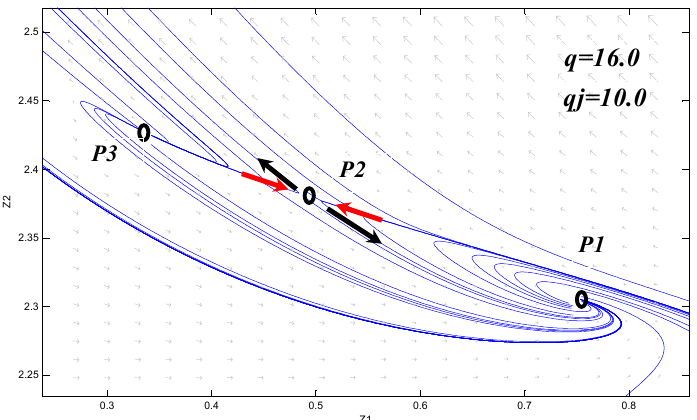
Figure 3. The phase plot for output multiplicity, where q j = 10m 3 /sand q = 16 m 3 /s.